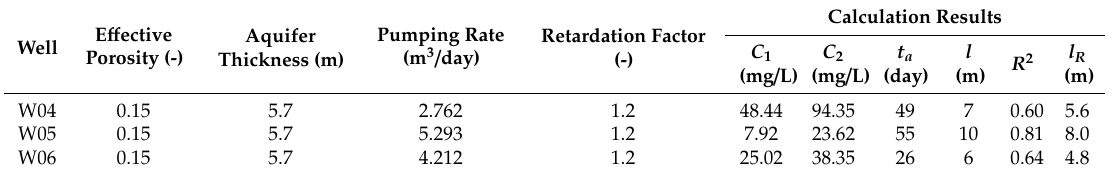
Figure 4. Nitrobenzene concentration measured in pumping wells, fitting curves, and identified point of t a , ( a ) well W04, ( b ) well W05, and ( c ) well W06. Table 1. Fitting and calculation results of the three pumping wells.